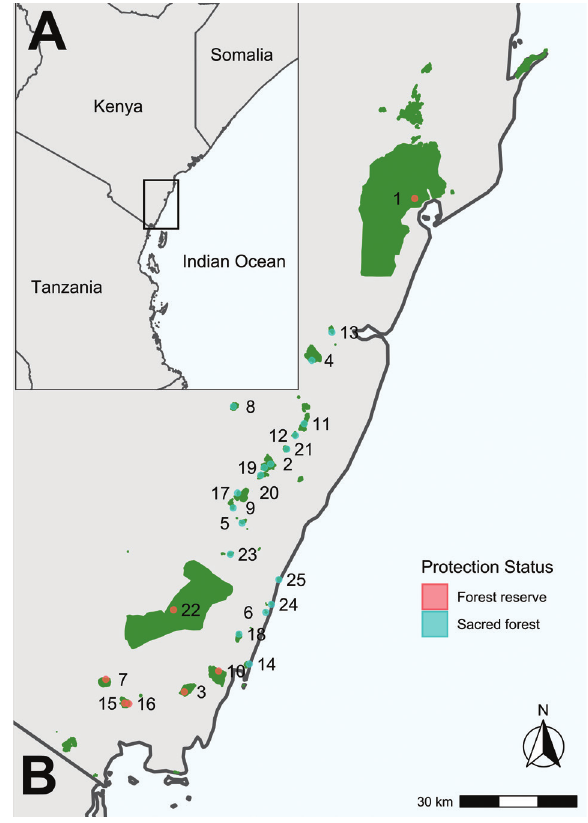
Figure 1. A Map of Eastern Africa area highlighting the coastal area of Kenya. B Coastal forests of Kenya span- ning from North to South (all forests identified by green colour with and without numbers), the numbered are the sampled sites with their protection status. 1 = Arabuko, 2 = Bomu, 3 = Buda, 4 = Chivara, 5 = Chonyi, 6 = Diani, 7 = Dzombo, 8 = Fungo, 9 = Gandini, 10 = Gogoni, 11 = Jibana, 12 = Kambe, 13 = Kauma, 14 = Kinondo, 15 = Marenje, 16 = Mrima, 17 = Mtswaka, 18 = Muhaka, 19 = Muvya, 20 = Mwi- ru, 21 = Ribe, 22 = Shimba, 23 = Teleza, 24 = Tiwi, 25 =